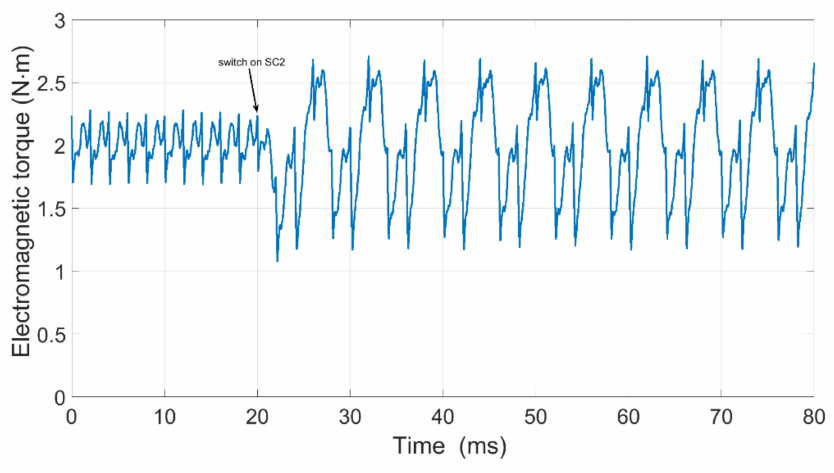
Figure 10. (cid:52) configuration—waveforms of electromagnetic torque delta—healthy to SC2. Figure 10 presents numerical tests illustrating the electromagnetic